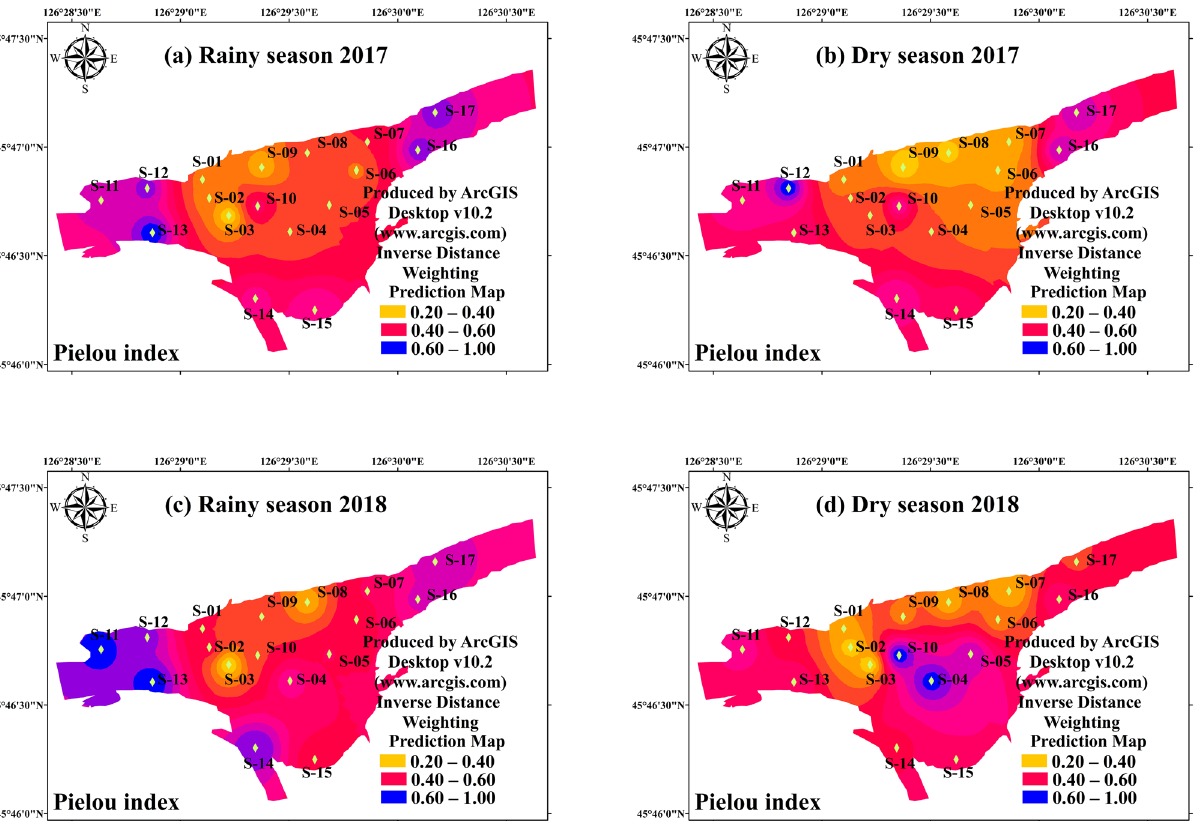
Figure 4. The spatial distribution of phytoplankton Pielou evenness index in study period. ( a ) Rainy season (July 2017); ( b ) Dry season (October 2017); ( c ) Rainy season (July 2018); ( d ) Dry season (October 2018). The interpolation map was constructed by ArcGIS software using the Inverse Distance Weighting method. The maps were created using software ArcGIS Desktop v10.2 (www.arcgi